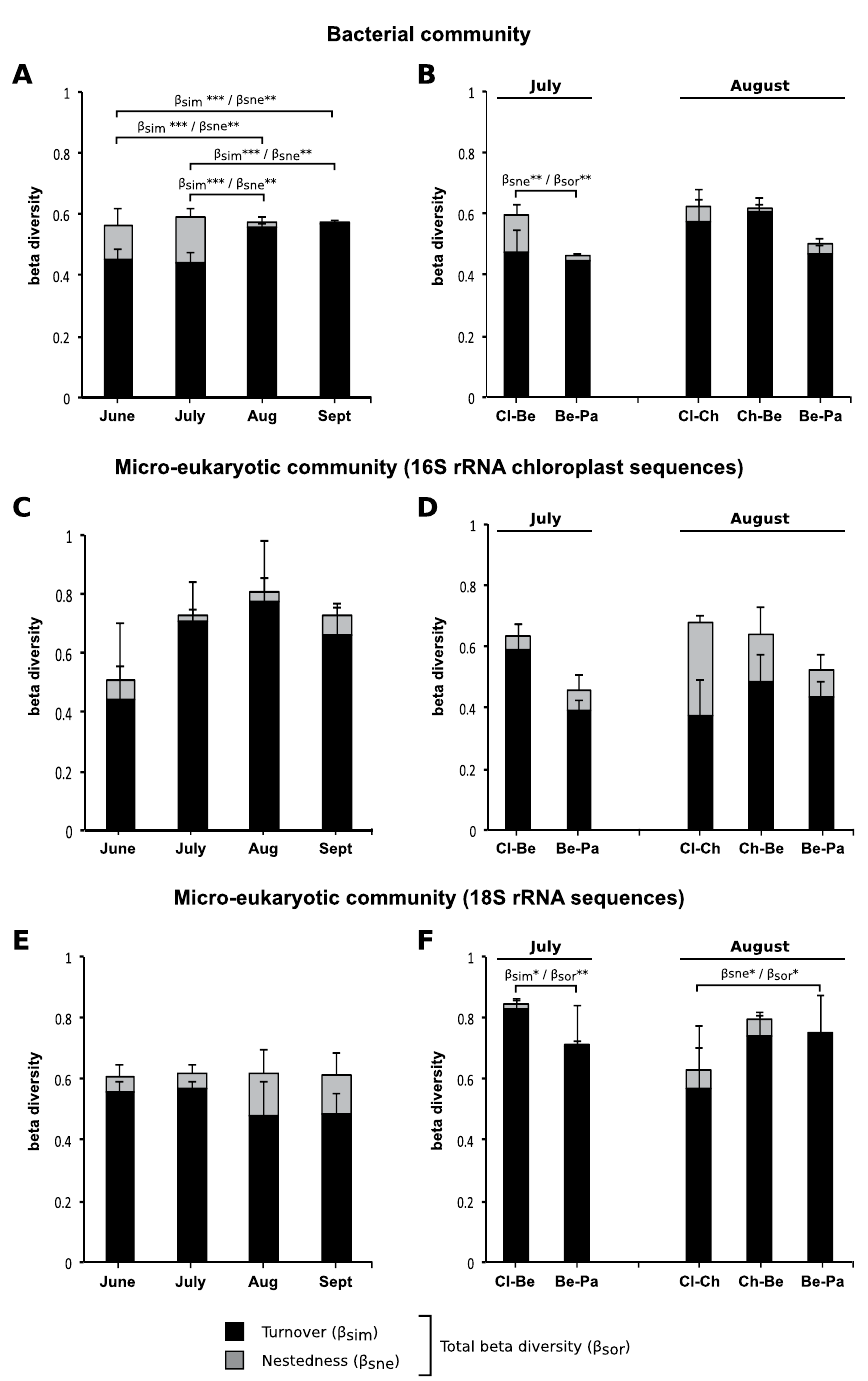
Figure 3. Temporal variation in the beta diversity of the bacterial ( A , 16S rRNA gene) and microeukaryotic communities ( C , 16S rRNA chloroplast sequences; E , 18S rRNA gene) between the Cléron and Parcey sampling stations and the spatial variation in the beta diversity in the bacterial ( B , 16S rRNA gene) and microeukaryotic communities ( D , 16S rRNA chloroplast sequences; F , 18S rRNA gene) in July and August. Histograms represent total beta diversity ( β sor ), turnover ( β sim ) = black, and nestedness ( β sne ) = gray. Error bars represent the standard deviation. Only statistically significant differences are noted: * < 0.05, ** < 0.01, *** < 0.001. Abbreviations: Aug, August; Sept, September; Cl, Cléron; Ch, Chamblay; Be, Belmont; Pa,